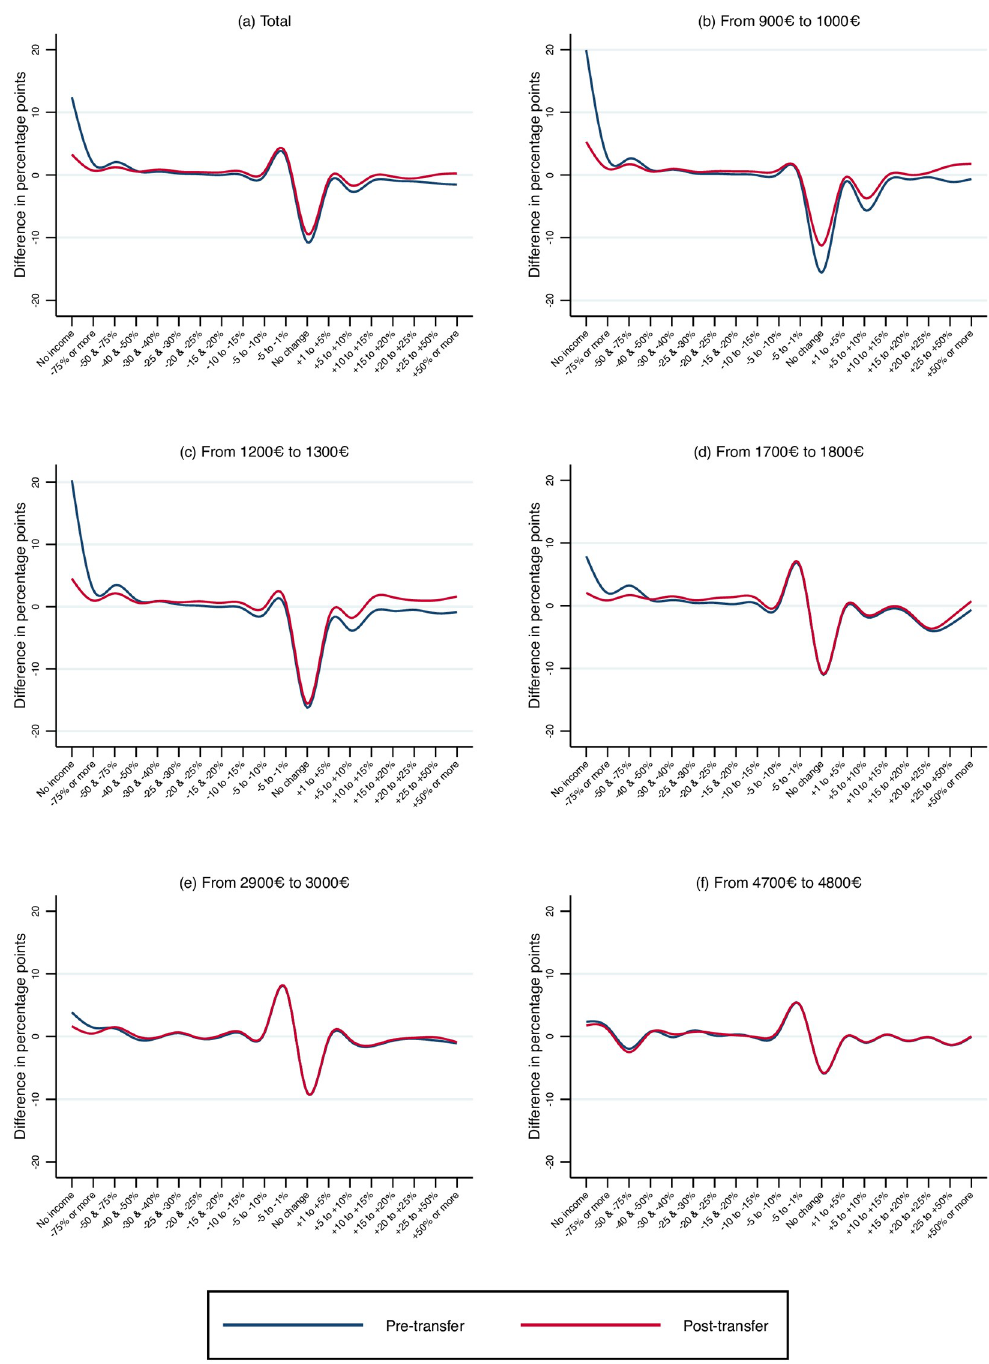
Fig 3. Diff-in-diffs in payments for each level of salaries in the reference month. April vs February—2020 vs